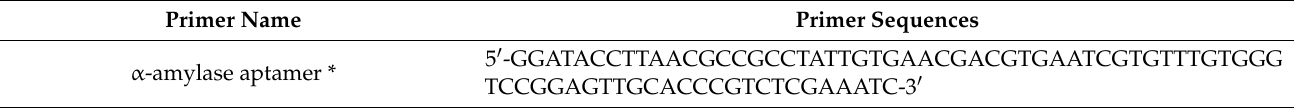
Table 1. Sequence of an α -amylase specific aptamer (75